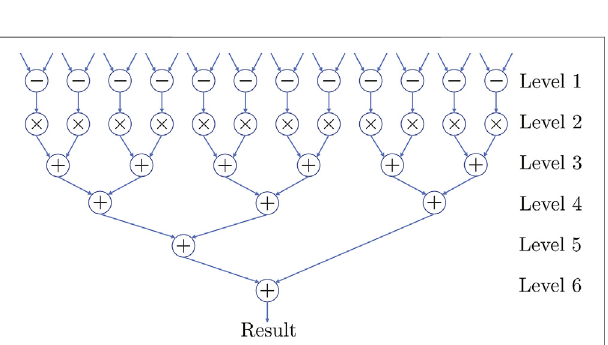
FIGURE 8 | Multilevel datapath for computing the Euclidean distance between the input data (12D) and the input alphabet, which takes six clock cycles.